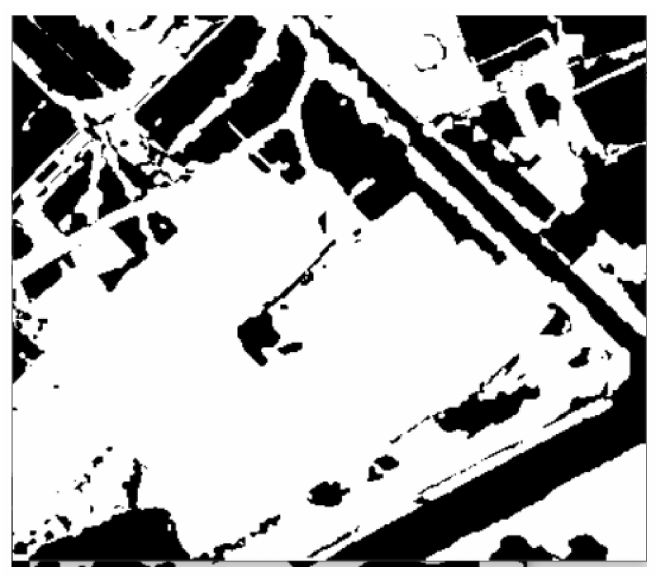
Figure 14. Truth round image.